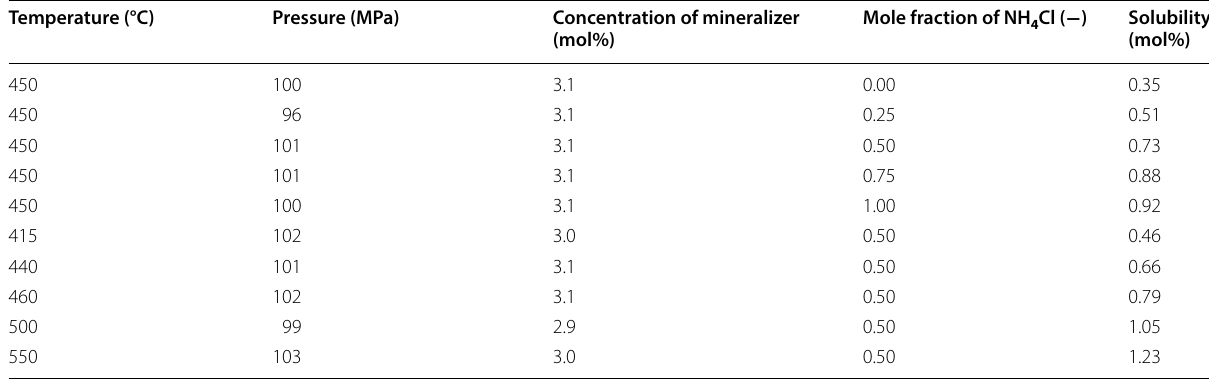
Cl NH Br mixed mineralizer 4 4 +